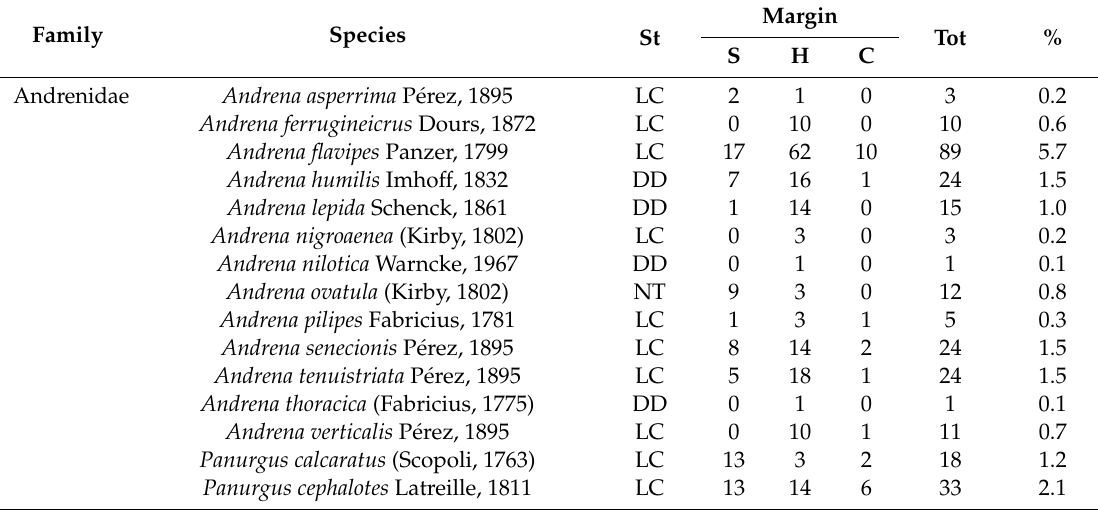
Table 2. List of species found in pan traps of shrubby (S), herbaceous (H) and control (C) margins. Red list status (St): DD (Data Deficient), VU (Vulnerable), LC (Least Concern), EN (Endangered), NT (Near Threatened) and CR (Critical Endangered). Tot, total number of individuals captured in pan traps; %, percentage of captures in relation to the total of